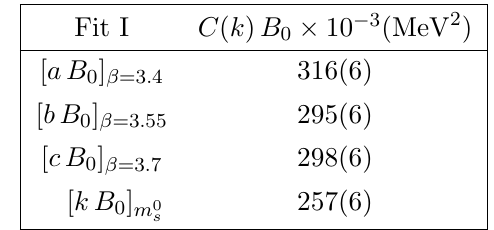
Table 2 . Values of parameters in the di(cid:11)erent chiral trajectories